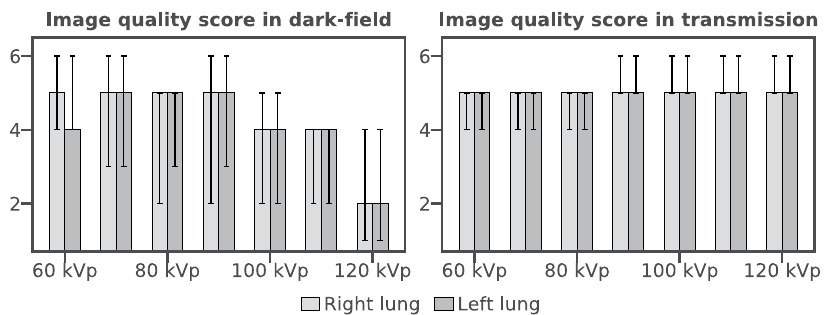
Figure 4. Image quality score (median and range) of dark-field (right) and transmission (left) images for the examined tube voltages. Image quality score decreases for higher tube voltages in dark-field images. In transmission images, the score remains